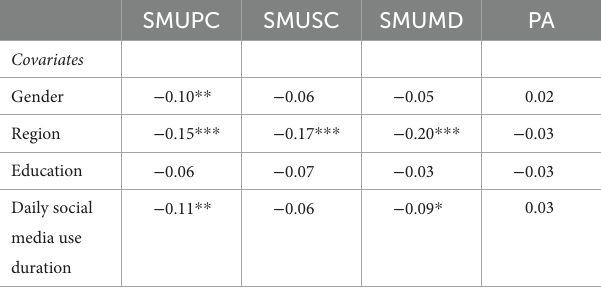
TABLE 2 Bivariate correlations among covariates and key